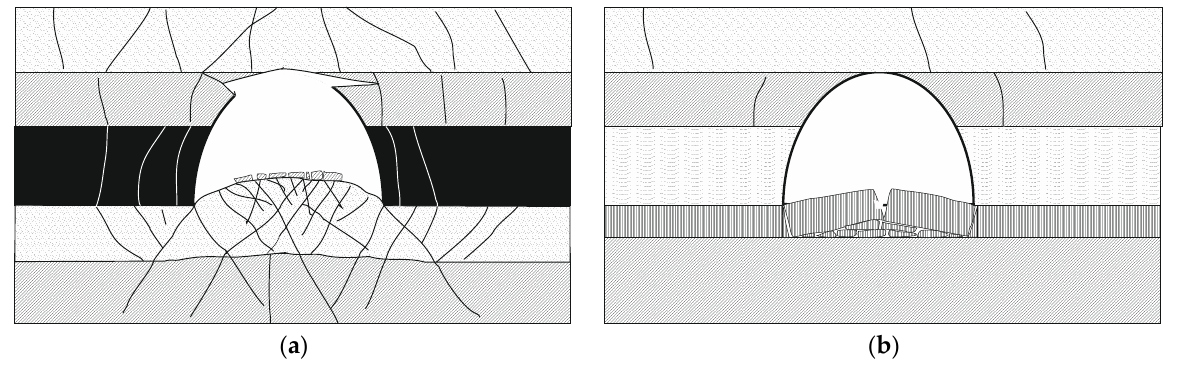
Figure 1. Heave of floor rocks. ( a ) Weak rocks, ( b ) strong rocks.